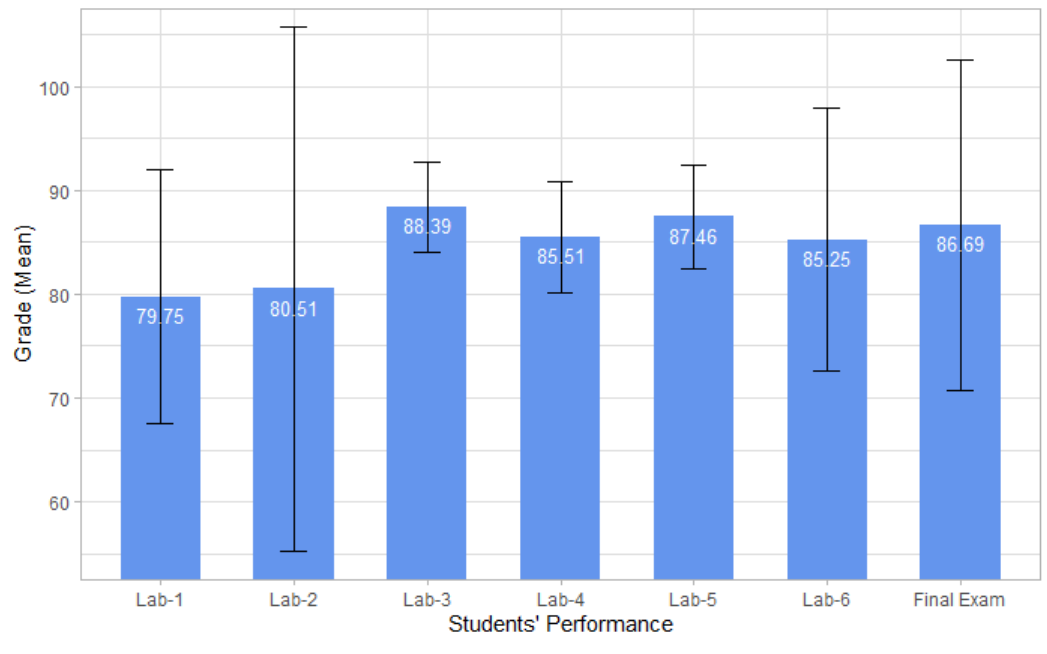
Mean of Weekly Reports and Final Examination Grade (n = 59